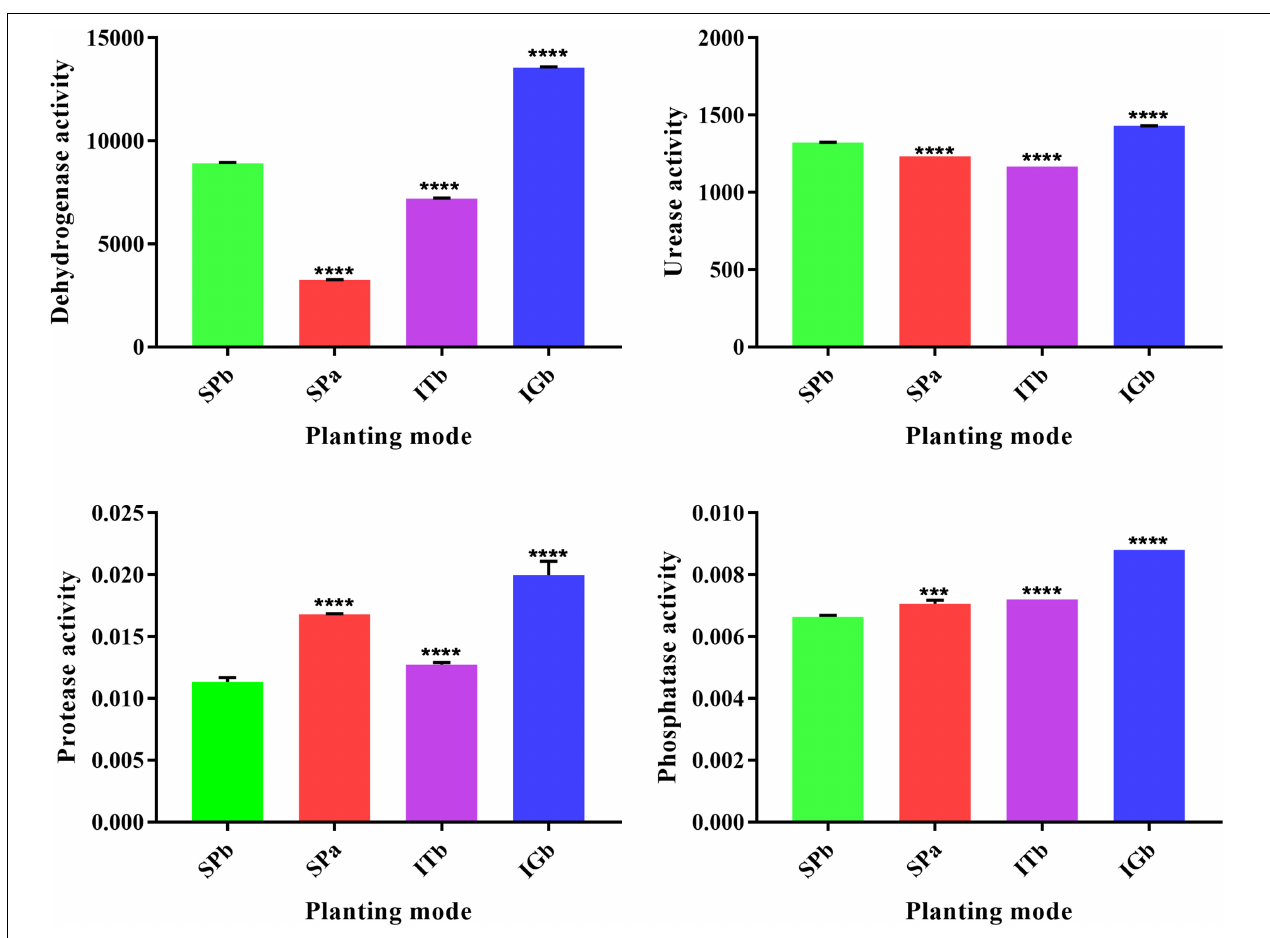
FIGURE 2 | Soil enzyme activities when the various planting modes were applied. **** P < 0.0001, ***0.0001 < P < 0.005, and ns, no significant difference.